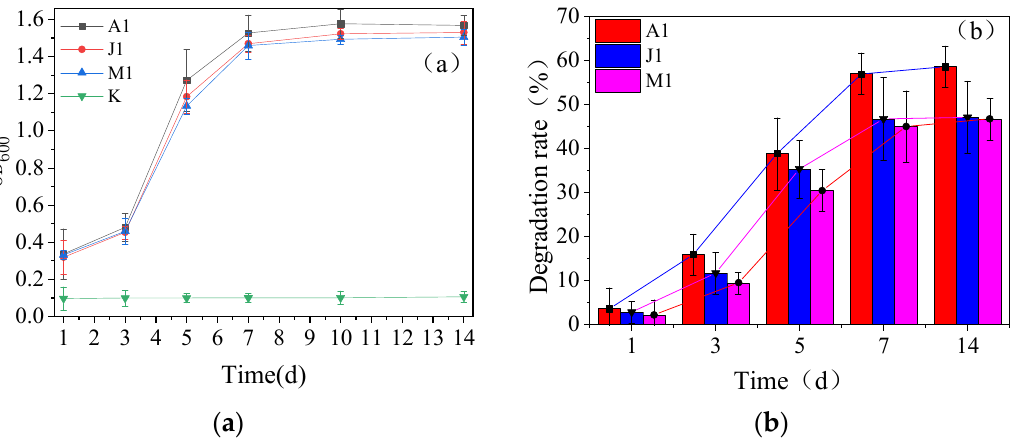
Figure 2. Effects of degradation time on strain growth ( a ) and β -HCH degradation ( b ).